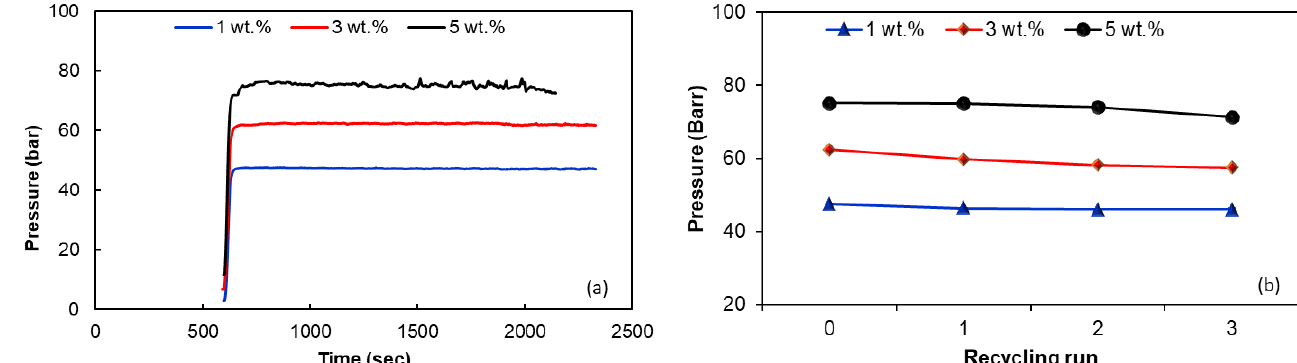
Figure 5. Thermo-stability curves for the virgin EVA/MWCNT nanocomposites ( a ) and the effect of recycling run on the melt pressure during capillary extrusion at 200 s − 1 and melt temperature of 180 °C ( b